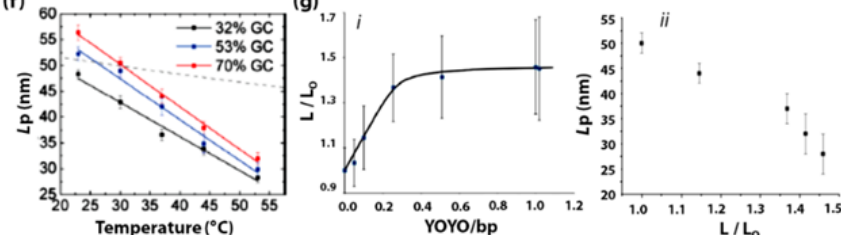
Figure 1. ( a ) A schematic of dsDNA showing chemical interactions and structural features such as base-pairing, base-stacking, phosphate-backbone, sugar pucker, respectively, and their contribution to the local rigidity in terms of mechanical strength of dsDNA. Figure adapted and modified from [3] with permission from The Royal Society of Chemistry. ( b ) Cartoon representation of dsDNA spontaneously bending upon incorporating neutral phosphate analogs (shown as ‘0’) on one of the helical faces. Negatively charged phosphates are shown as ‘-’ [11]. ( c ) Dependence of L p on the ionic strength of monovalent Li + , Na + (top red) and divalent Mg 2+ , Ca 2+ (bottom blue) ions. Figure reprinted with permission from [102]. Copyright (2019) by the American Physical Society. ( d ) A scatter plot of simulated and experimentally estimated poly(NN) dsDNA persistence length (L p ) data from different experiments pursued by various research groups (grouped by colour). Figure adapted with permission from [103]. Copyright 2016 American Chemical Society. ( e ) ( i ) shows the schematic of a single-molecule dsDNA cyclization experiment. Two complementary sticky ends of the dsDNA are tagged with a fluorescence resonance energy transfer (FRET) pair of fluorescent donor (D) and acceptor (A) dyes, and the fraction of the dsDNA looped is probed by monitoring the increase in FRET between A and D. ( ii ) shows the fraction of the dsDNA looped as a function of time. Figure adapted with permission from [23]. Copyright 2016, the authors. ( f ) Dependence of L p of three dsDNA (differing in their G-C content) on temperature. The melting temperature of all three dsDNA used in this experiment are greater than 75 °C. Figure adapted with permission from [32]. Copyright 2014 American Chemical Society. ( g ) ( i ) shows the change in dsDNA length upon YOYO intercalation. L and L o is the contour length of dsDNA in the presence and absence of YOYO, respectively. The curve demonstrates the increase in fractional extension L/L o upon an increase in YOYO concentration. ( ii ) shows the dependence of L p on fractional extension L/L o . The curve demonstrates that L p decreases upon the increase of the YOYO/base-pair ratio. Figure adapted from [48] with permission from The Royal Society of Chemistry.